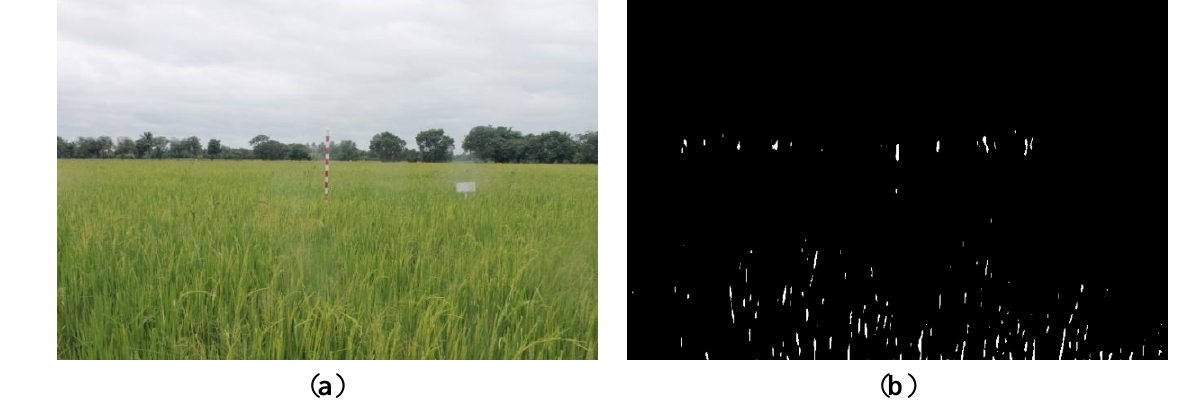
Figure 17. Comparison between ( a ) RGB and ( b ) resultant binary images using proposed method with red band feature on 19 July